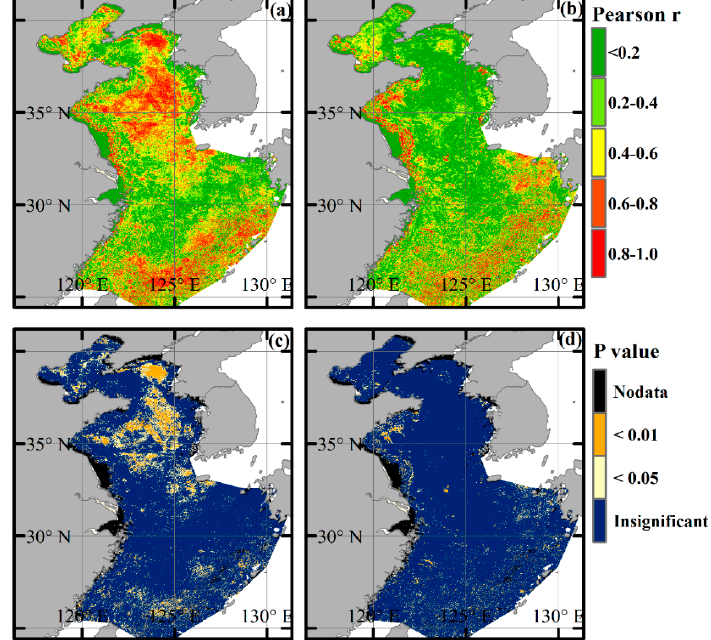
Figure 13. Partial correlation coefficients (P value) of TSS biases with cloud coverage ( a , c ), and TSS biases with TSS CV ( b , d ) at the monthly scale. Table 3. Area percentage statistics: P values for each subregion at the monthly scale.